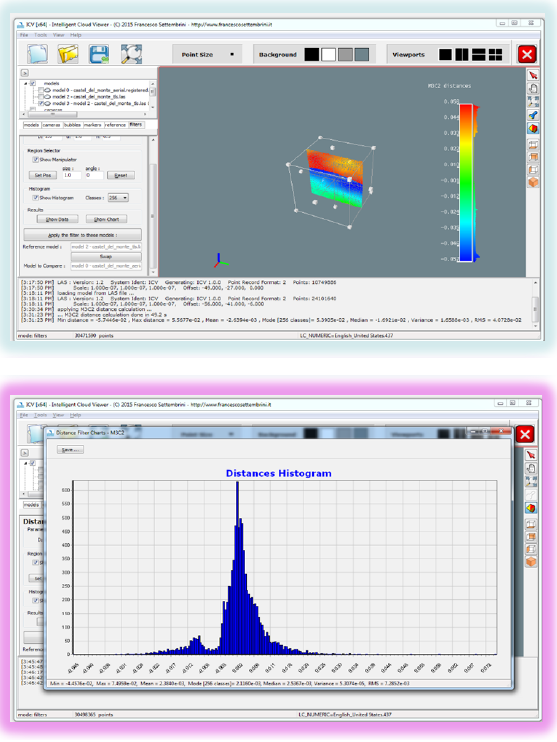
Figure 28. Output comparison with